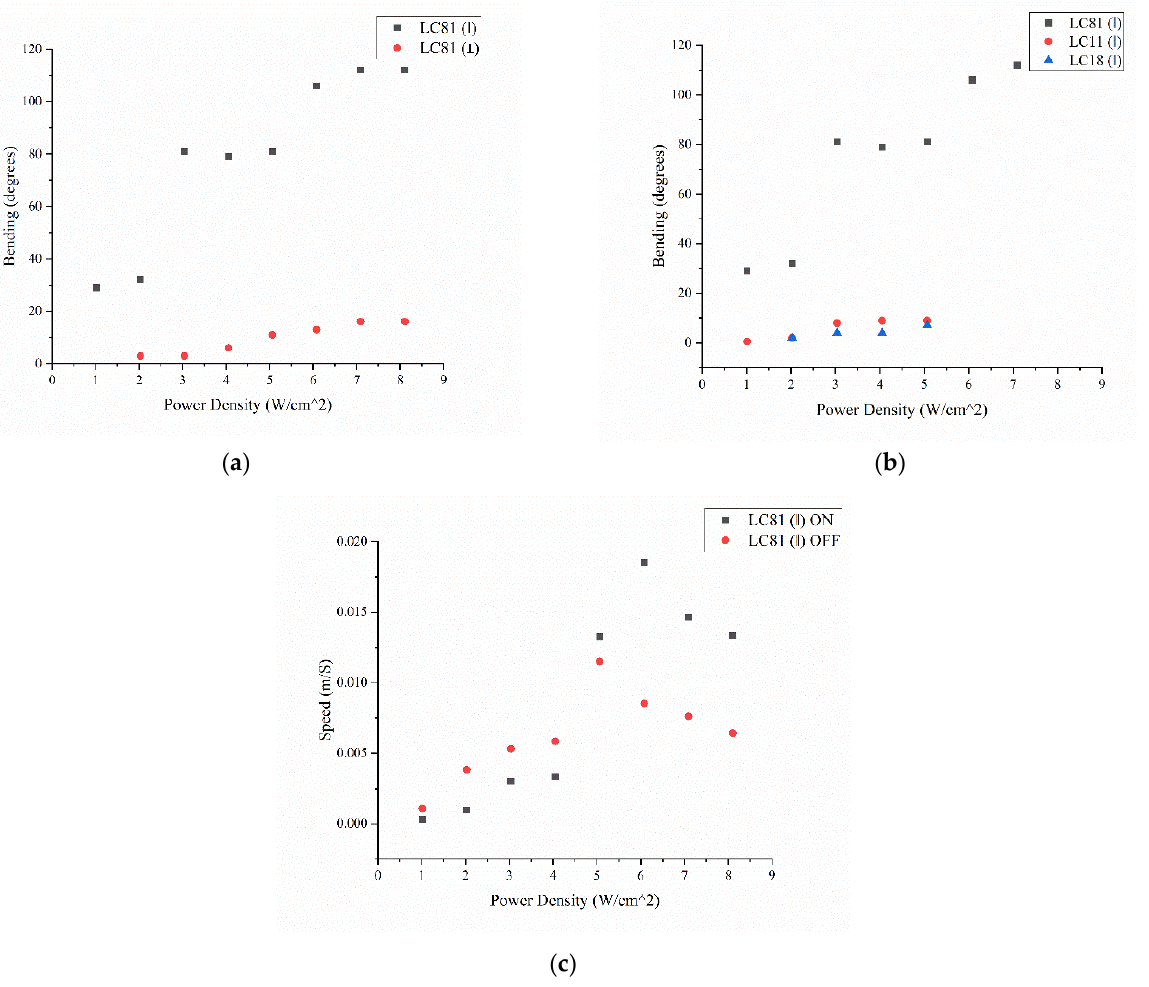
Figure 7. ( a ) Bending of LC81 when irradiated with polarized light parallel and perpendicular to the rubbing direction, ( b ) bending of LC81, LC18, and LC11 irradiated by polarized light parallel to the rubbing direction, and ( c ) bending speed of LC81 when the laser is ON and OFF.